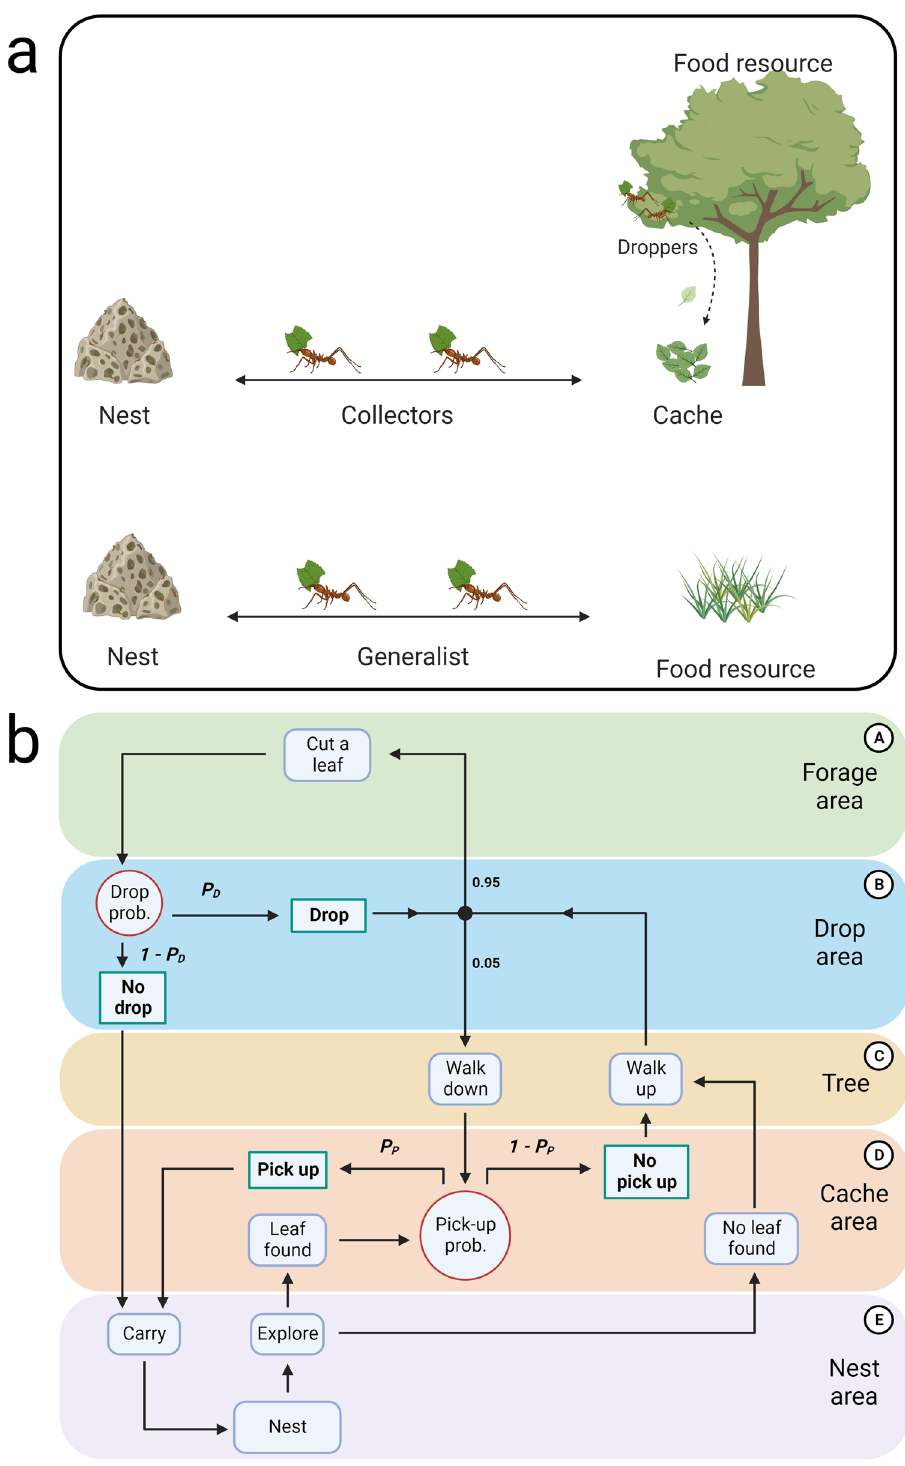
Figure 1. Overview of the model system and simulation design. ( a ) Visual representation of the two types of foraging strategies observed in leaf-cutter ants, task-partitioned (top) and generalist (bottom). Under task partitioning, individuals either cut and drop leaves from the treetop (‘droppers’) or collect and return the dropped leaves on the ground (‘collectors’). In contrast, generalists individually cut and return leaves to the nest. ( b ) Schematic representation of the model showing the different areas of the arena and the corresponding ant decisions and actions in each area. The red circles indicate the two key behavioural variables in the model: the tendency to drop leaves from the tree (given by the ‘drop probability’, P D ) and the tendency to pick up leaves in the cache area (given by the ‘pick-up probability’, P P ). Depending on these probabilities, the ant will decide to act or not, indicated by the green boxes. A third decision node in the Drop area (B) controls forage probability, fixed at 0.95, to implement a small amount of noise in the system, allowing the ants to dynamically balance flows between the areas. Created with